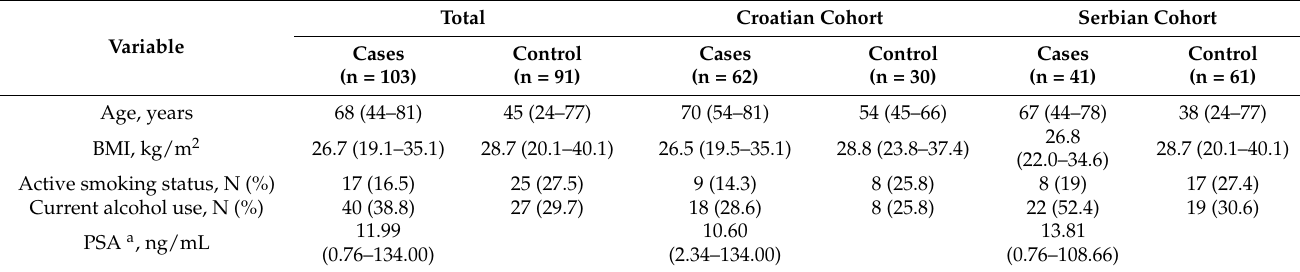
Table 1. Demographic characteristics of prostate cancer patients and controls.